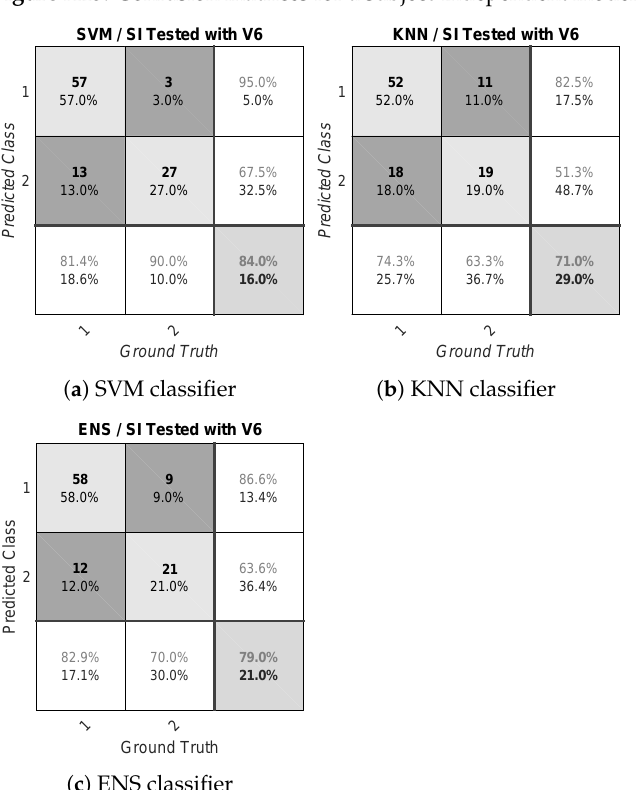
Figure A15. Confusion matrices for a subject-independent model tested with V5.